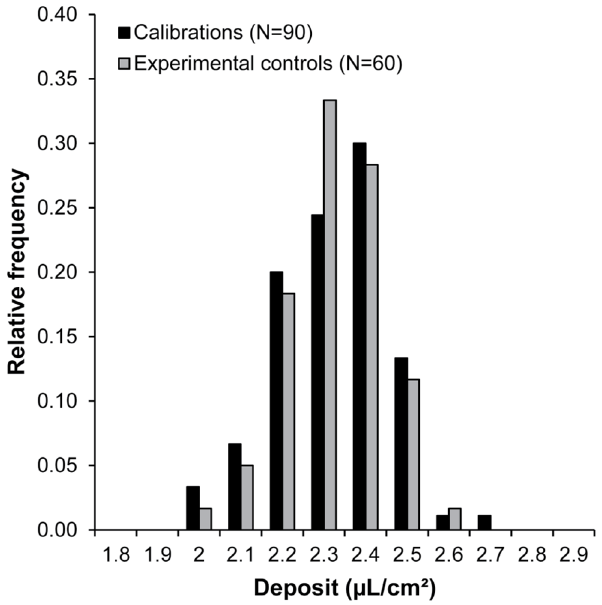
Figure 1. Distribution of the deposit during preliminary calibrations and experimental controls. The preliminary calibra- tions were performed before the experiment, and the experimental calibrations were performed during the experiment. The deposit was expressed in m L/cm 2 of the disc. T-test preliminary vs. experimental calibrations; (t=0.0739, df=148, p-value=0.9412).